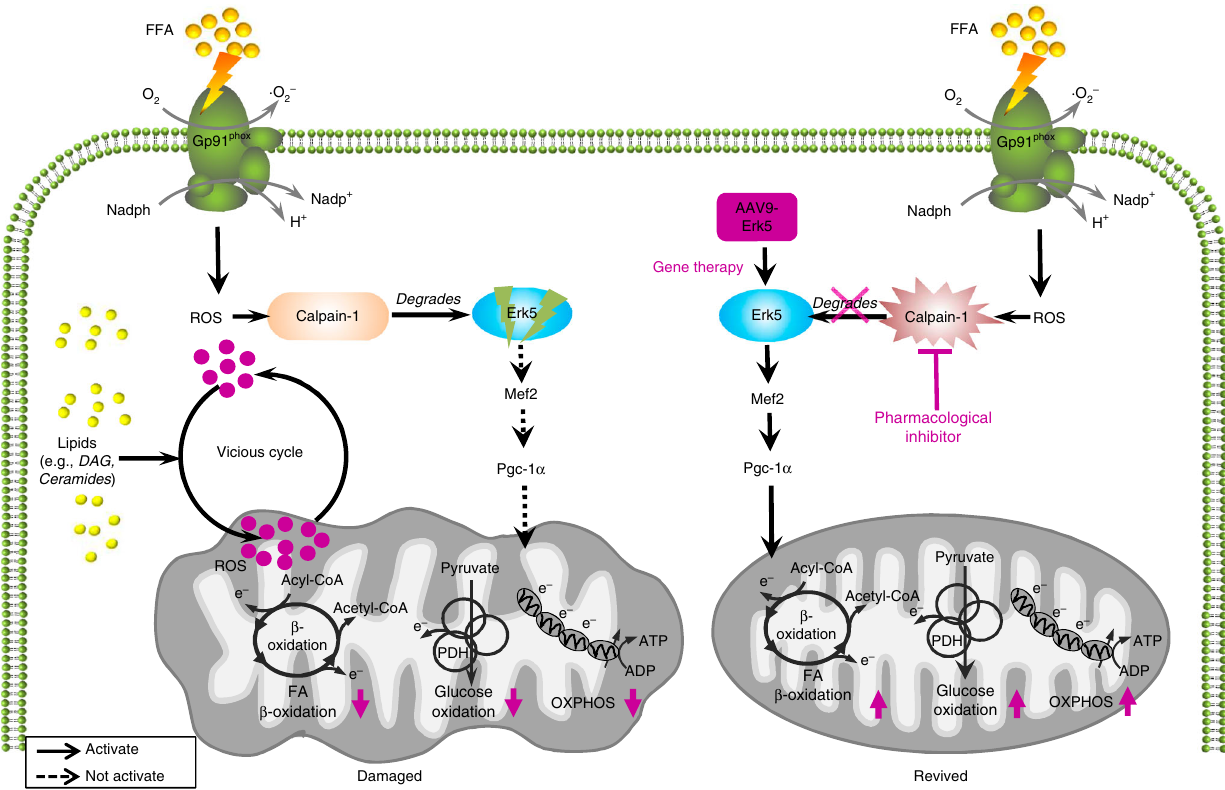
Fig. 9 Schematic model of Erk5 protection against metabolic stress. FFA induces escalated ROS production from Gp91phox, which activates caplain-1, leading to a breakdown of Erk5. Loss of Erk5 and resultant Pgc-1 α downregulation impose detrimental impacts on mitochondrial functions through accumulation of toxic lipids and vicious cycle of ROS. Prevention of Erk5 degradation or Erk5 restoration by AAV9 approach revives mitochondrial